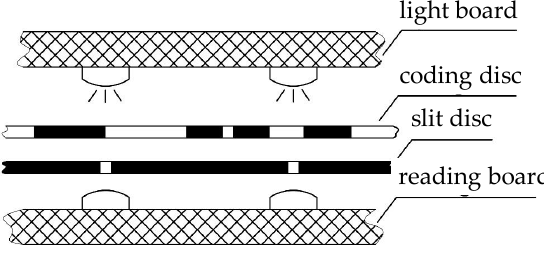
Figure 8. The structural schematic of the prototype.